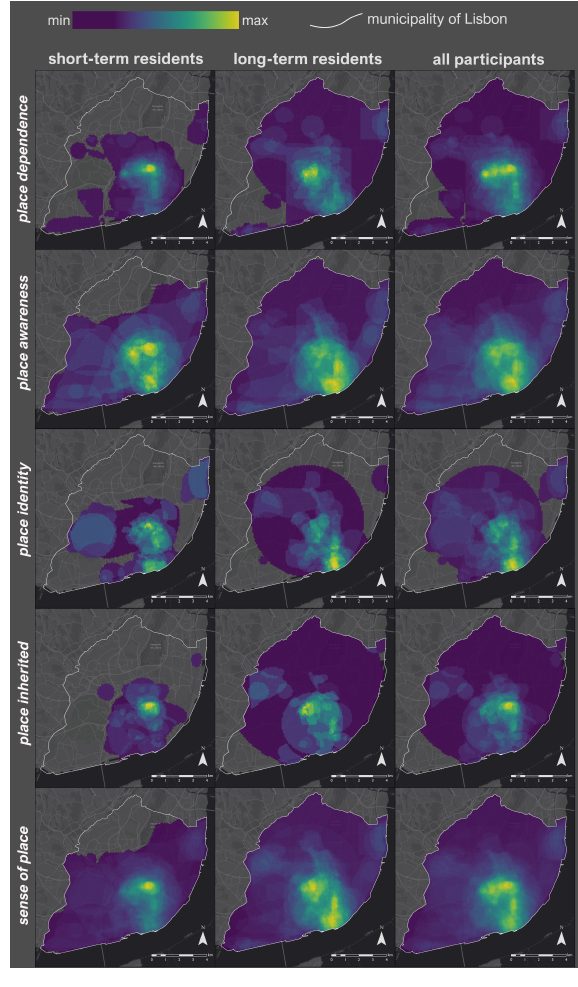
Figure 2: Normalized overlap values of the distribution of sense of place and its dimensions within the city of